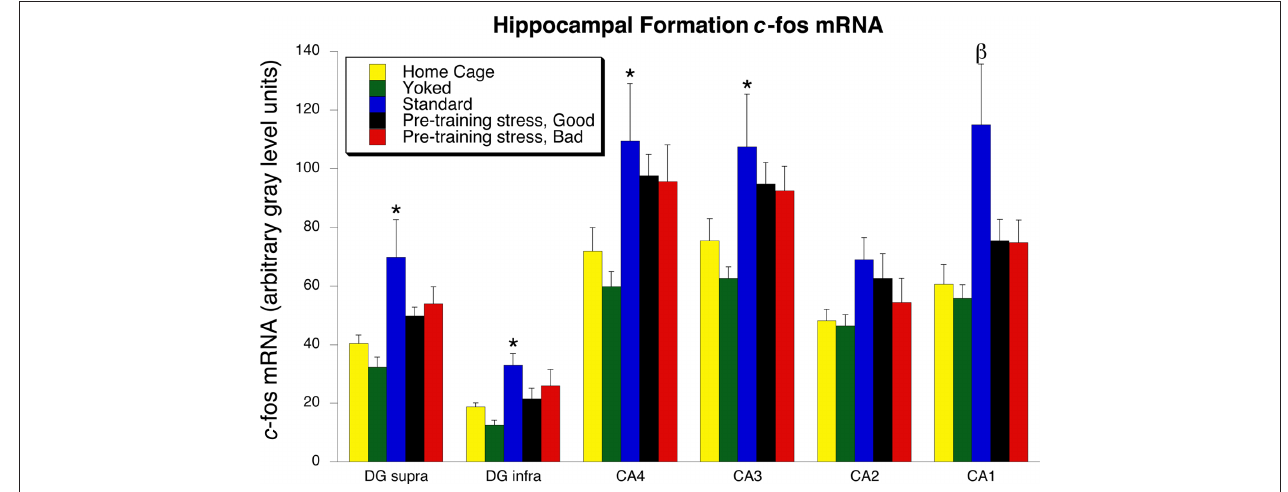
that the expression of c-fos mRNA was significantly greater in CA1 than in the home cage and both Pre-Training Stress groups. * p < 0.05 relative to the Home Cage group (SNK post hoc test). All hippocampal tissue was assayed in the same in situ films, thereby allowing for expression of the data in terms of arbitrary gray